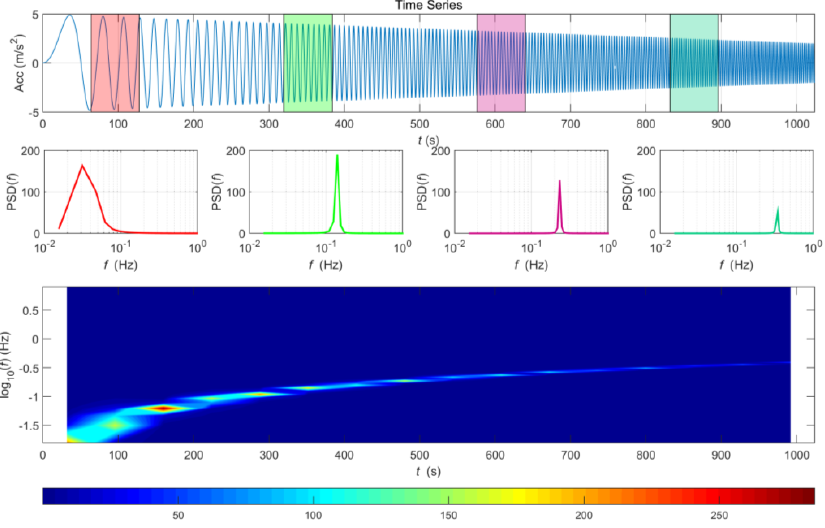
Figure 10. Short-time Fourier Transform (STFT) results for signals in which the amplitude and frequency change over time. change over